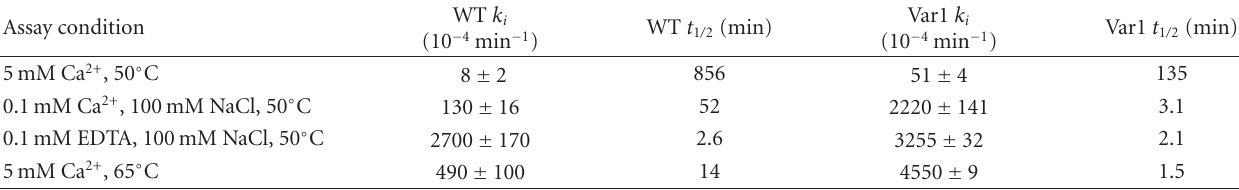
Table 3: Thermal inactivation parameters ( k i and t 1 / 2 ∗ ) of wild-type AprE and AprE Δ L 75 –L 82 T 66 M G 102 D (Var1). Assay condition